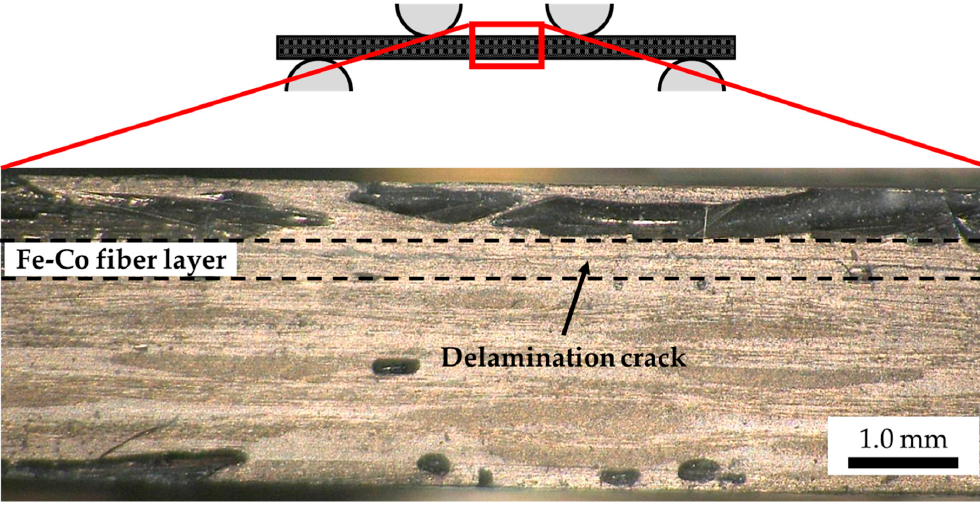
Figure 6. Edge view of the specimen.